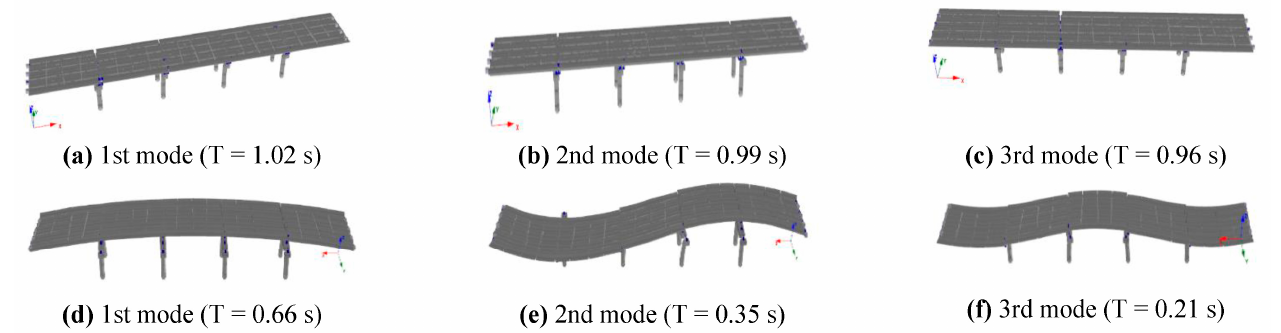
Figure 11. Modes of vibration of the bridge: ( a – c ) longitudinal direction and ( d – f ) transverse direction.